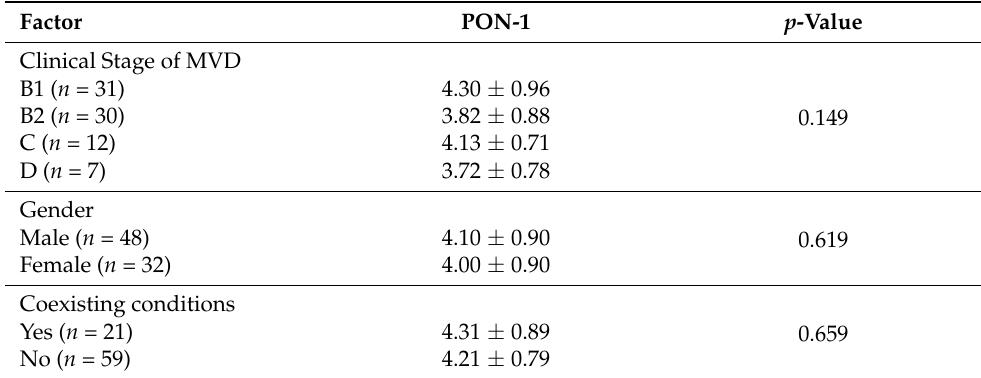
Table 2. Descriptive statistics (mean ± standard deviation) with the results of the correspond- ing testing (ANOVA or t -test) for different factors affecting the concentration of PON-1. (PON-1: Paraoxonase-1; MVD: Mitral Valve Disease).